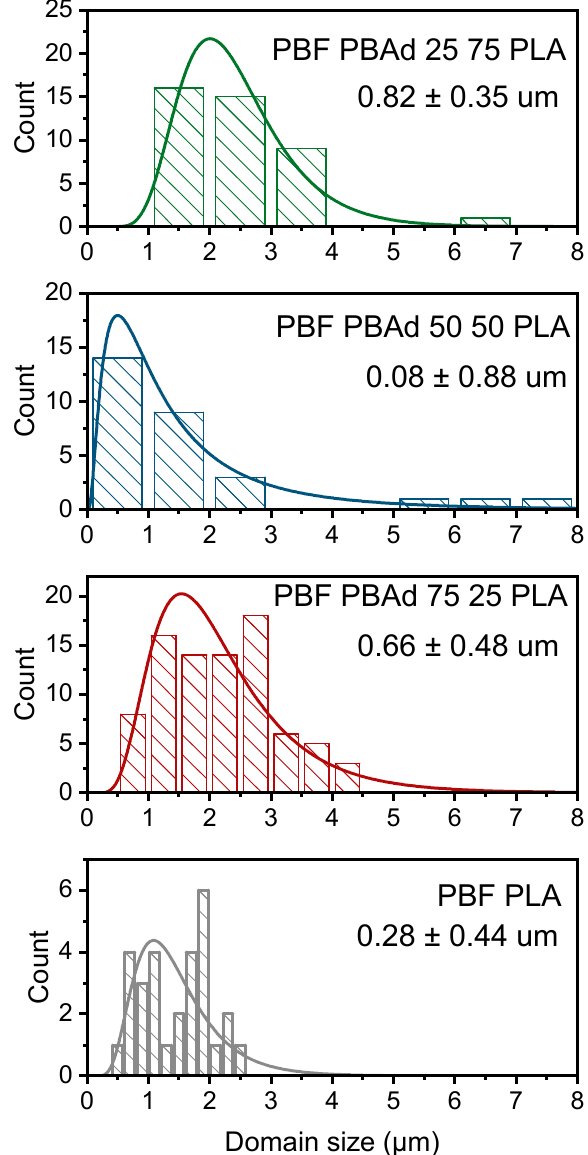
Figure 2. Histograms of the domain size and lognormal distribution curve. The FTIR spectra of the homopolymers, the copolymers and their blends are shown in Figure 3. PLA, due to its high molecular weight, had weak absorption bands of terminal hydroxyls at 3500 cm − 1 . The C-H stretching appeared at ~2900 cm − 1 and ~2945 cm − 1 , the C=O stretching at 1752 cm − 1 , the -CH 3 asymmetric stretching at 1453 cm − 1 and the C-O-C stretching at 1185–1080 cm − 1 . The spectra of PBF and its blend with PLA are presented in Figure 3a. In the spectrum of PBF, the terminal -OH peak at ~3600 cm − 1 was visibly stronger than in PLA. The asymmetric and symmetric stretching of the furan ring can be seen at 3150 cm − 1 and 3120 cm − 1 , respectively [10,15,43]. The bands in the range of 2900–2800 cm − 1 corresponded to the vibrations of the methyl groups of butanediol, and the band at 1732 cm − 1 to the C=O stretching. The bands of the C-H and C=H vibrations of the furan ring were visible at 1580 and 1530 cm − 1 , respectively [10,36]. After blending PLA with the FDCA-based polyesters, a combination of the bands of the two components appeared on the spectra (Figure 3, middle spectra). It is noteworthy that the band of the terminal -OH groups was weaker, and the position of the C=O band of the FDCA-based component shifted to smaller wavenumbers, indicating that some limited